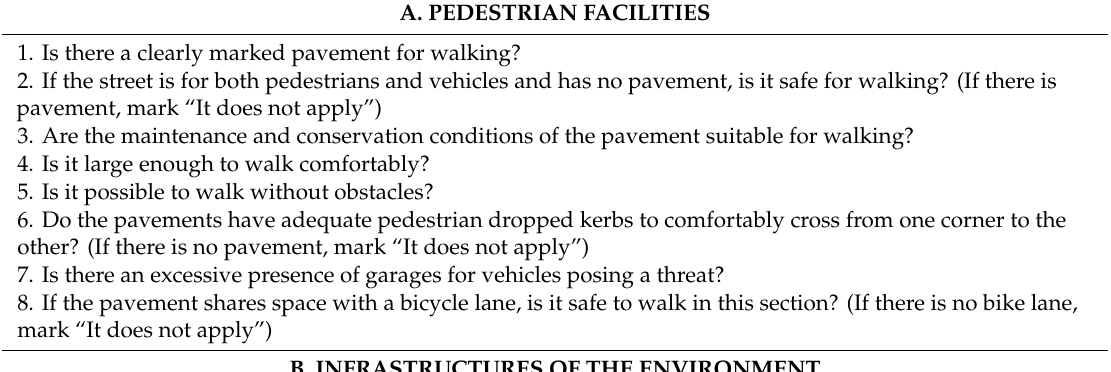
Table A3. Definitive urban walkability perception questionnaire (UWPQ) in the Balearic